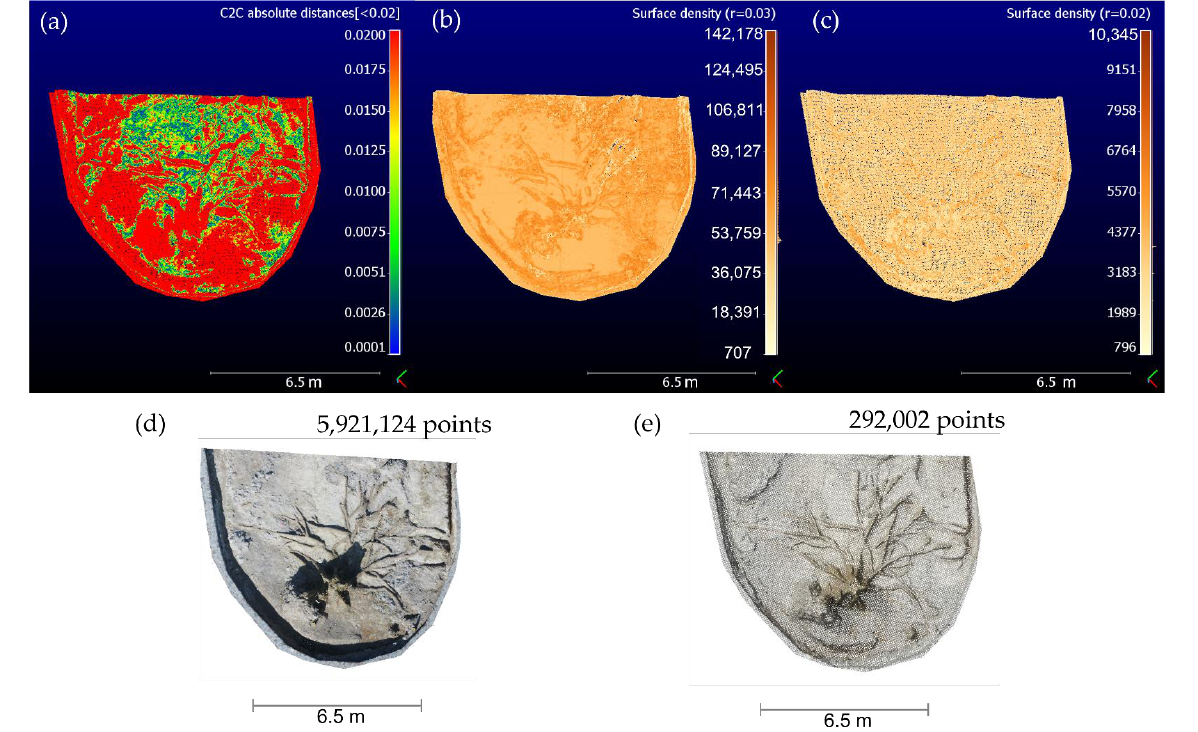
Figure 5. Comparison of point clouds of the petrified root system: ( a ) cloud to cloud distance, ( b ) surface density of RS-1, ( c ) surface density of RS-2, ( d ) RGB point cloud of RS-1 and ( e ) RGB point cloud of RS-2.